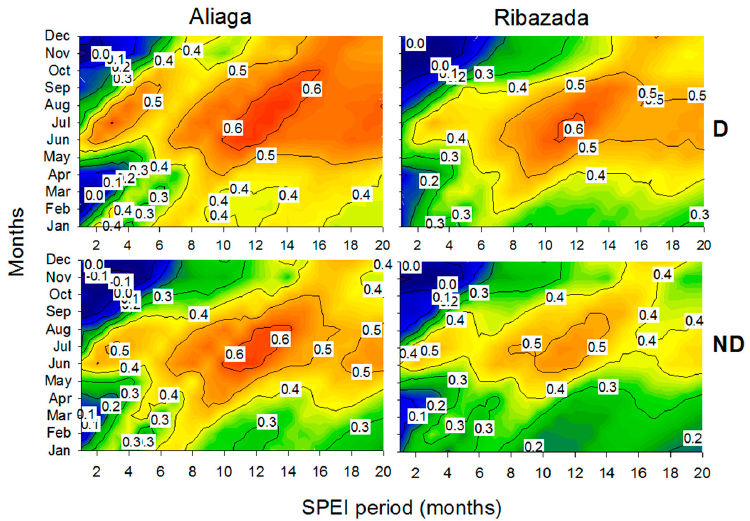
Figure 5. Drought-growth relationships based on Pearson correlations calculated between series of ring-width indices of declining (D) and non-declining (ND) junipers vs. monthly data of the SPEI drought index calculated at 1- to 20-month long periods (x axes).